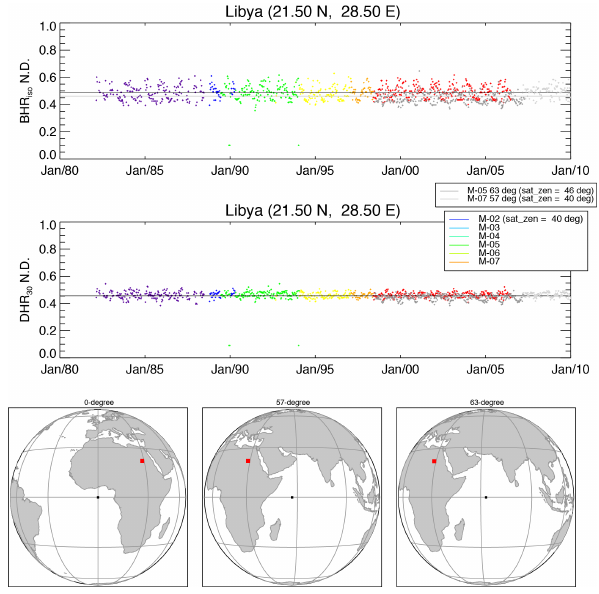
Figure 2. Same as Fig. 1 but for the Libyan Desert